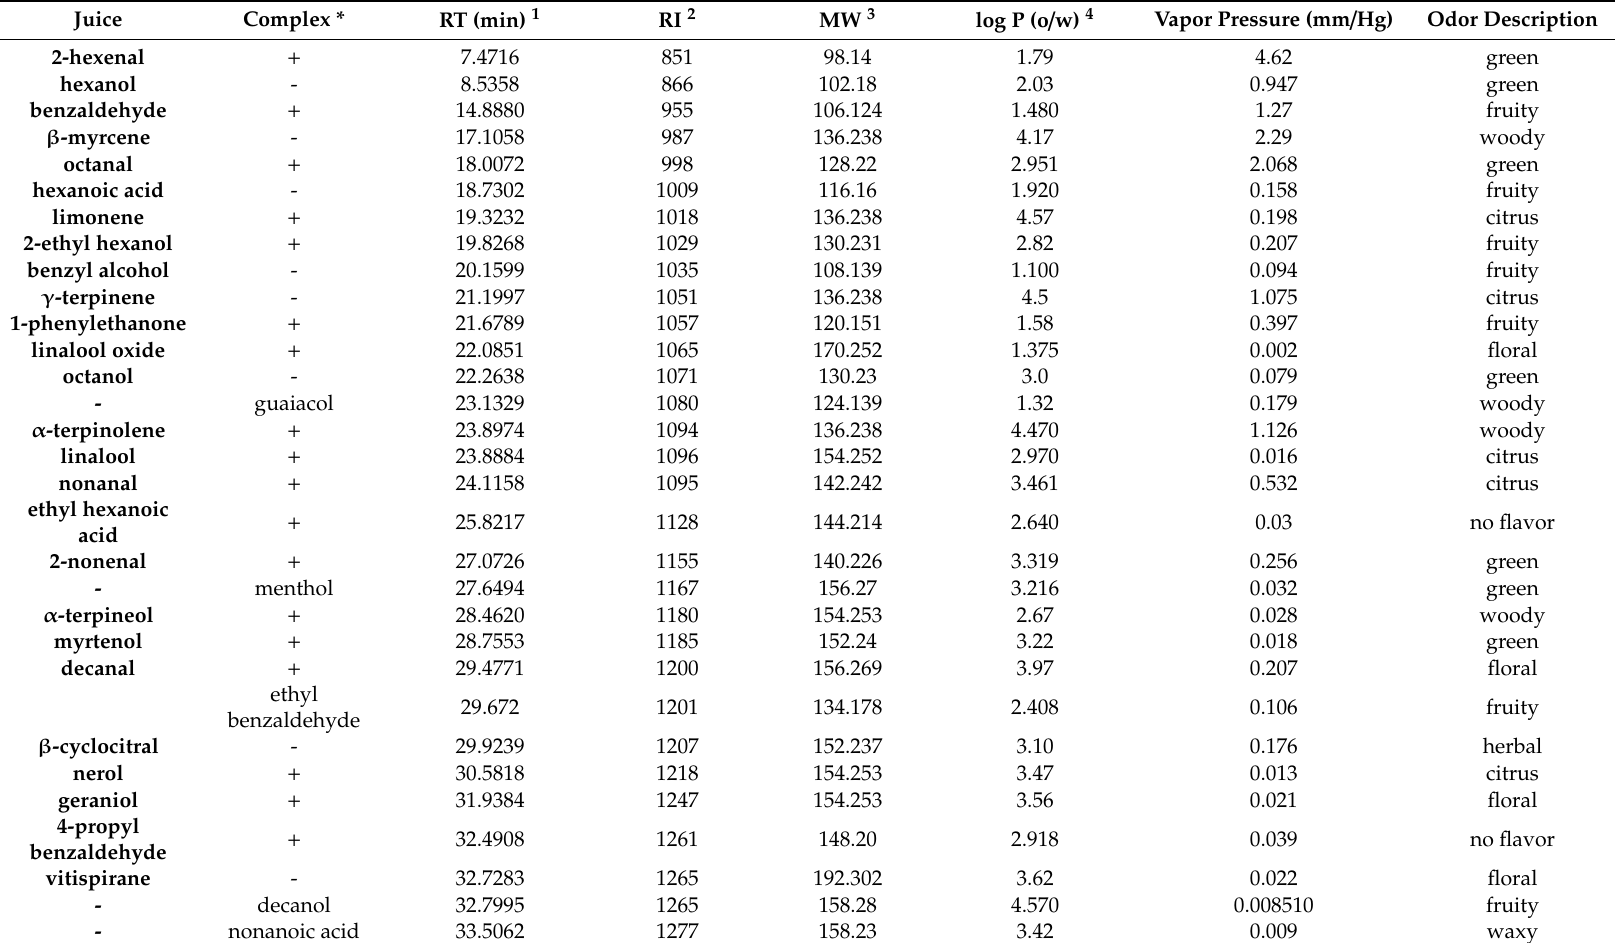
Table 1. Volatile compounds detected in raspberry juice and cellulose / raspberry